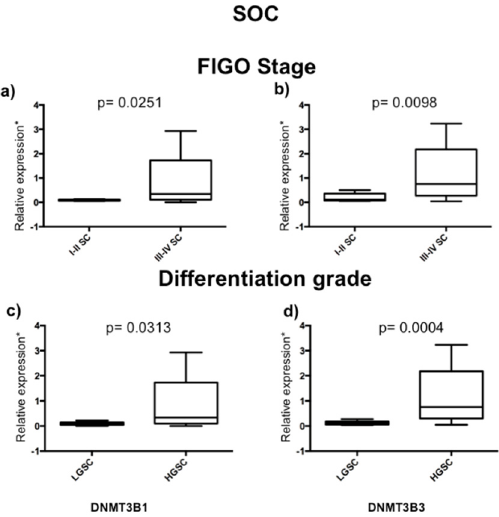
Figure 3. DNMT3B1 and DNMT3B3 expression according to grade and clinical stages in serous ovarian carcinoma (SOC). DNMT3B isoforms’ expression in serous ovarian carcinoma (n = 27): LGSOC (low-grade serous carcinoma) (n = 6) versus HGSOC (high-grade ovarian carcinoma) (n = 21) and stages I–II (early disease stages) (n = 6) versus stages III–IV (advanced stages) (n = 21). DNMT3B1: ( a ) grade and ( c ) stage, and DNMT3B3: ( b ) grade and ( d ) stage. Assays were normalized with GAPDH expression in each case and ten controls of the normal ovary. Mann–Whitney U test was used. * 1 + log-transformed.